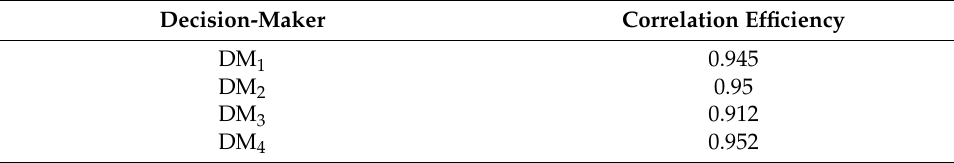
Table 5. Correlation efficiency of decision-makers.